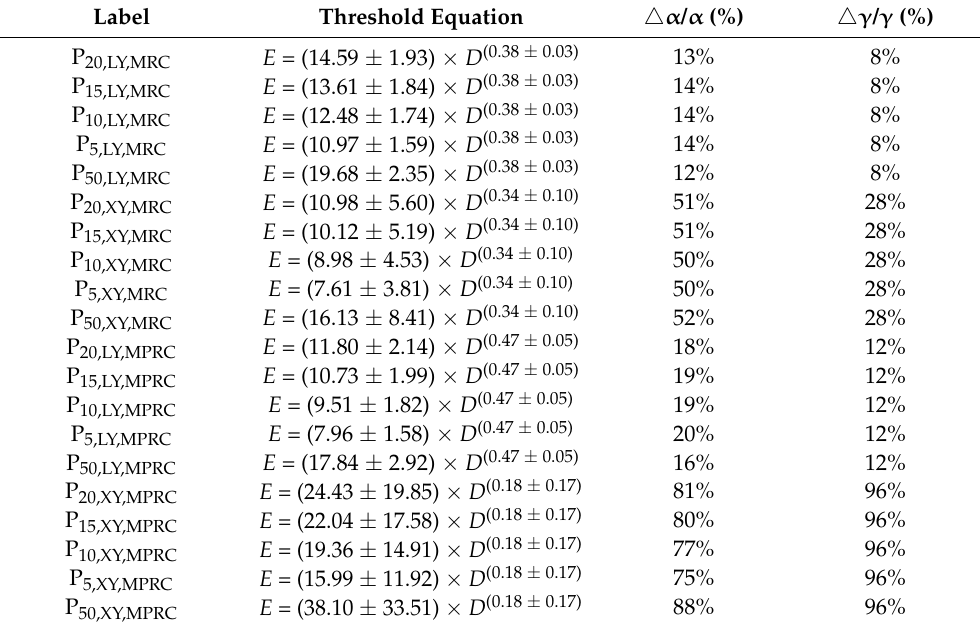
Figure 7. Defined positive rainfall thresholds based on MPRC: ( a ) LY county; ( b ) XY county. Table 5. Positive threshold functions and relative uncertainties of threshold parameters.